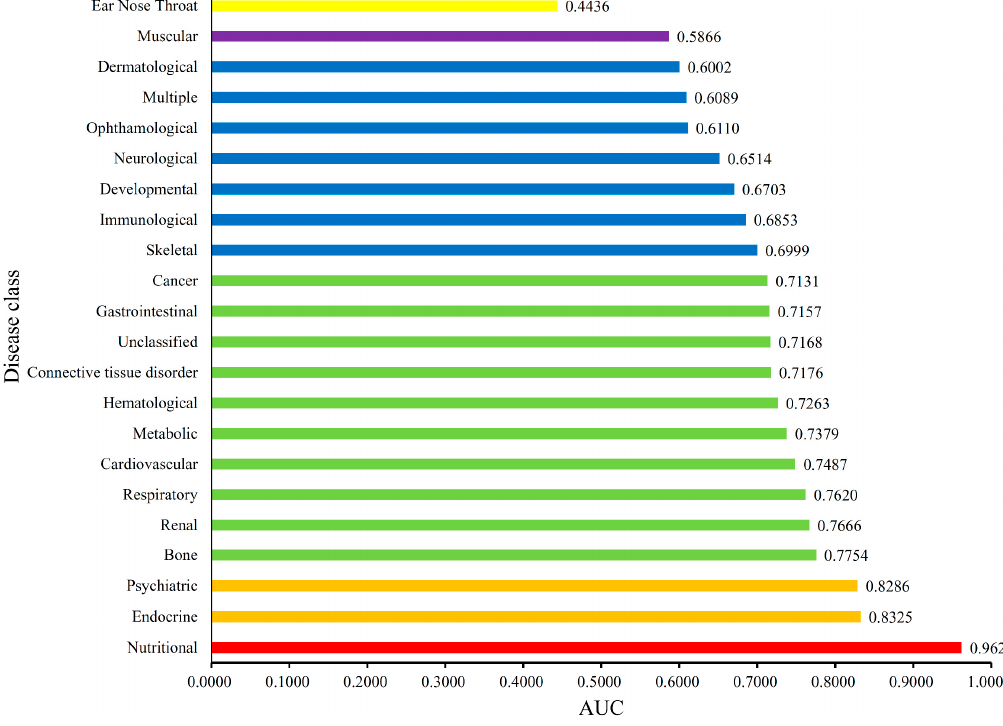
Figure 3. Bar chart of the Area Under Curves (AUCs) of 22 disease classes. The disease class “nutritional” received the highest AUC, thereby indicating that this class is inferred to be highly related to